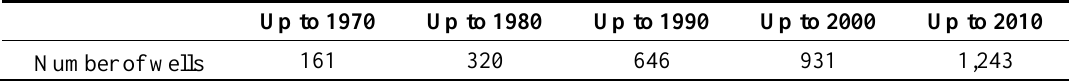
Table 4. Cumulative number of well in the study area, by decade (1970 through